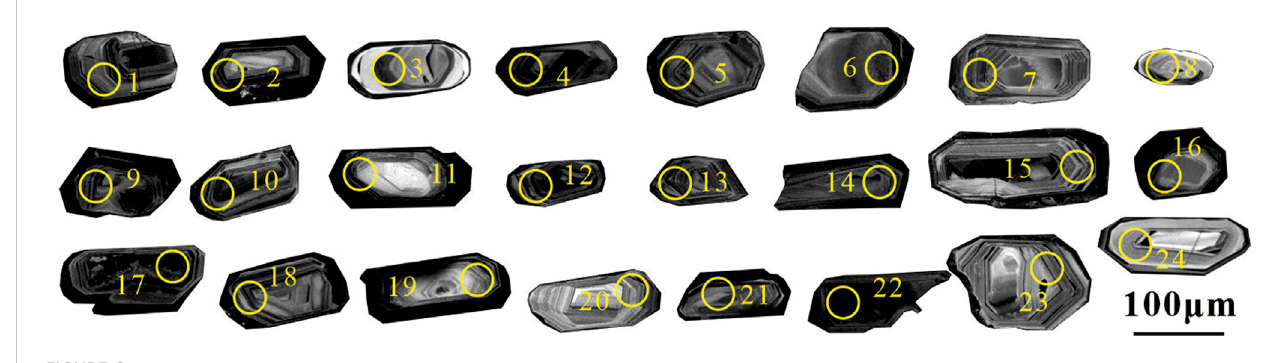
FIGURE 6 CL images and U-Pb data of zircons in diorite porphyrite (SD74B2).